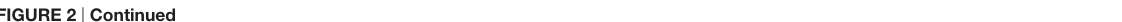
FiGUre 2 | Continued Functional analysis of deregulated SGALS in saLs1 . (a) The outer circle shows a scatter plot of the expression levels (logFC) for SALS1-related differentially expressed SGALS in each enriched gene ontology (GO) term: red circles indicate upregulation and blue ones downregulation. The inner ring is a bar plot where the height of the bar indicates the significance of GO terms (log10-adjusted P value), and color corresponds to the z-score: green, decreased; red, increased; and white, unchanged. (B) The plot shows the relationship between statistically significant SGALS in SALS1 and their related GO terms; for each gene, the logFC value is shown by red/blue colored rectangles. (C) Gene-concept networks by GO analysis for differentially expressed SGALS in SALS1, using GeneAnswers Package. Yellow hubs correspond to the most enriched GO terms; red and blue nodes represent downregulation and upregulation of SGALS in SALS1, respectively. The size of each yellow hub is proportional to the statistical significance of the identified genes in corresponding GO categories. Details are provided in Table S4 in Supplementary